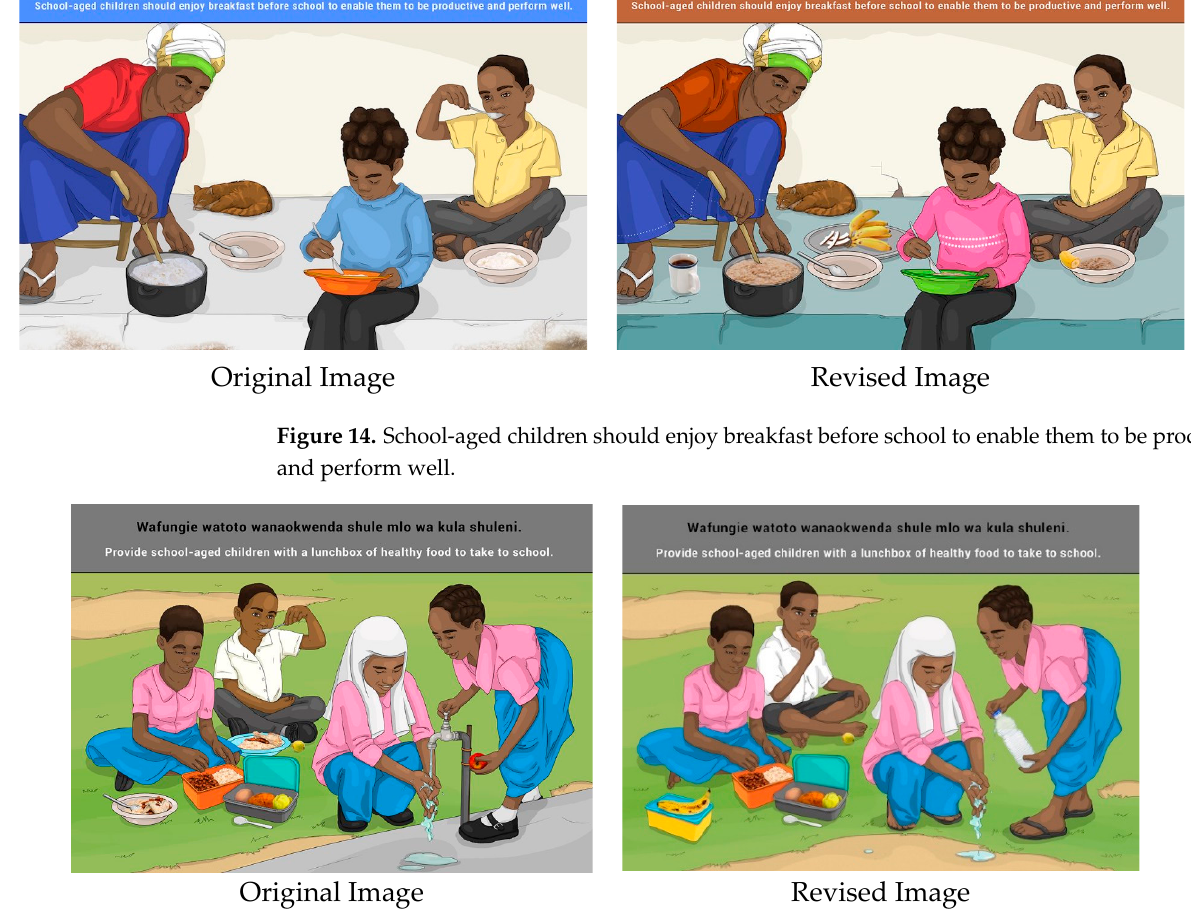
Figure 13. Encourage school-aged children to eat healthy snacks such as fresh fruit, vegetables and nuts. Figure 14. School-aged children should enjoy breakfast before school to enable them to be produc- tive and perform